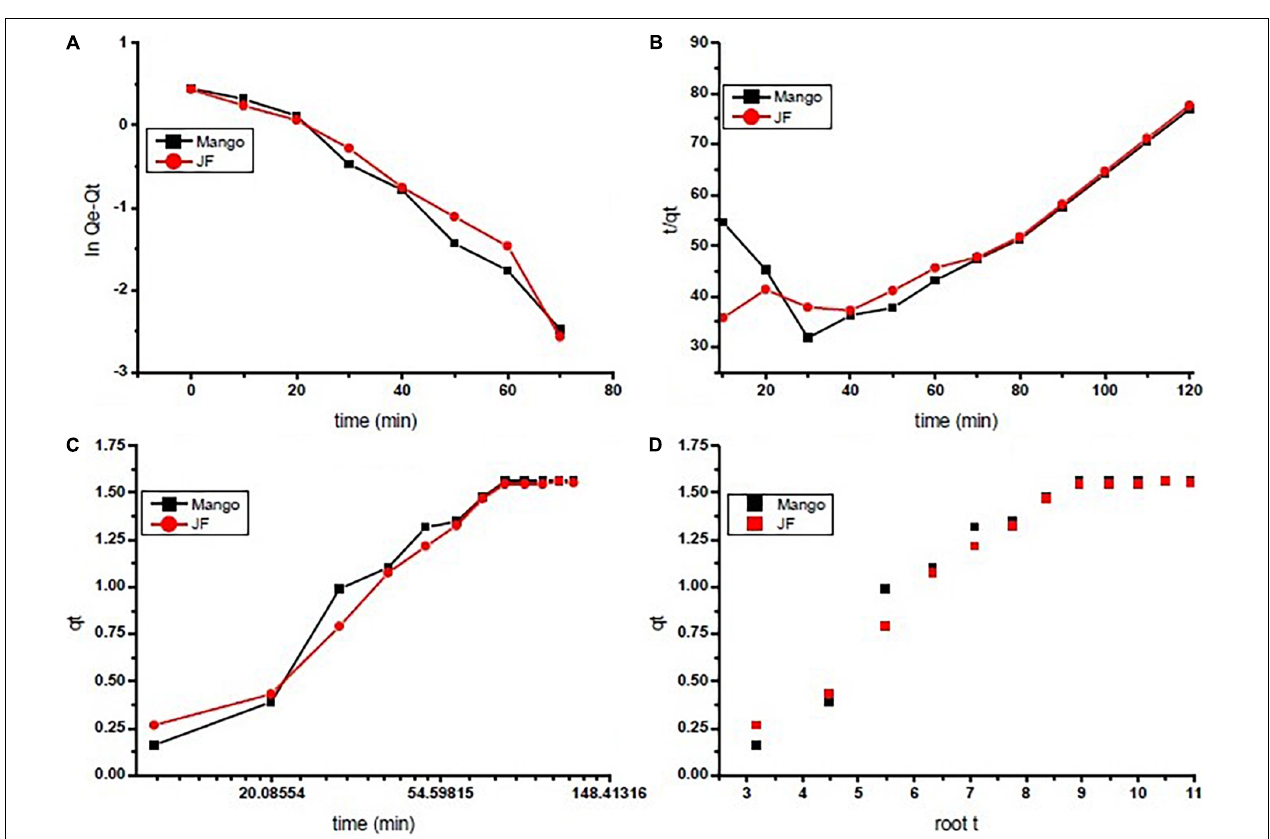
FIGURE 4 | Adsorption kinetics of chromium by using seed bio-sorbent of Mango (M) and Jackfruit (JF): (A) first order, (B) second order, (C) Elovich, and (D) interparticle.